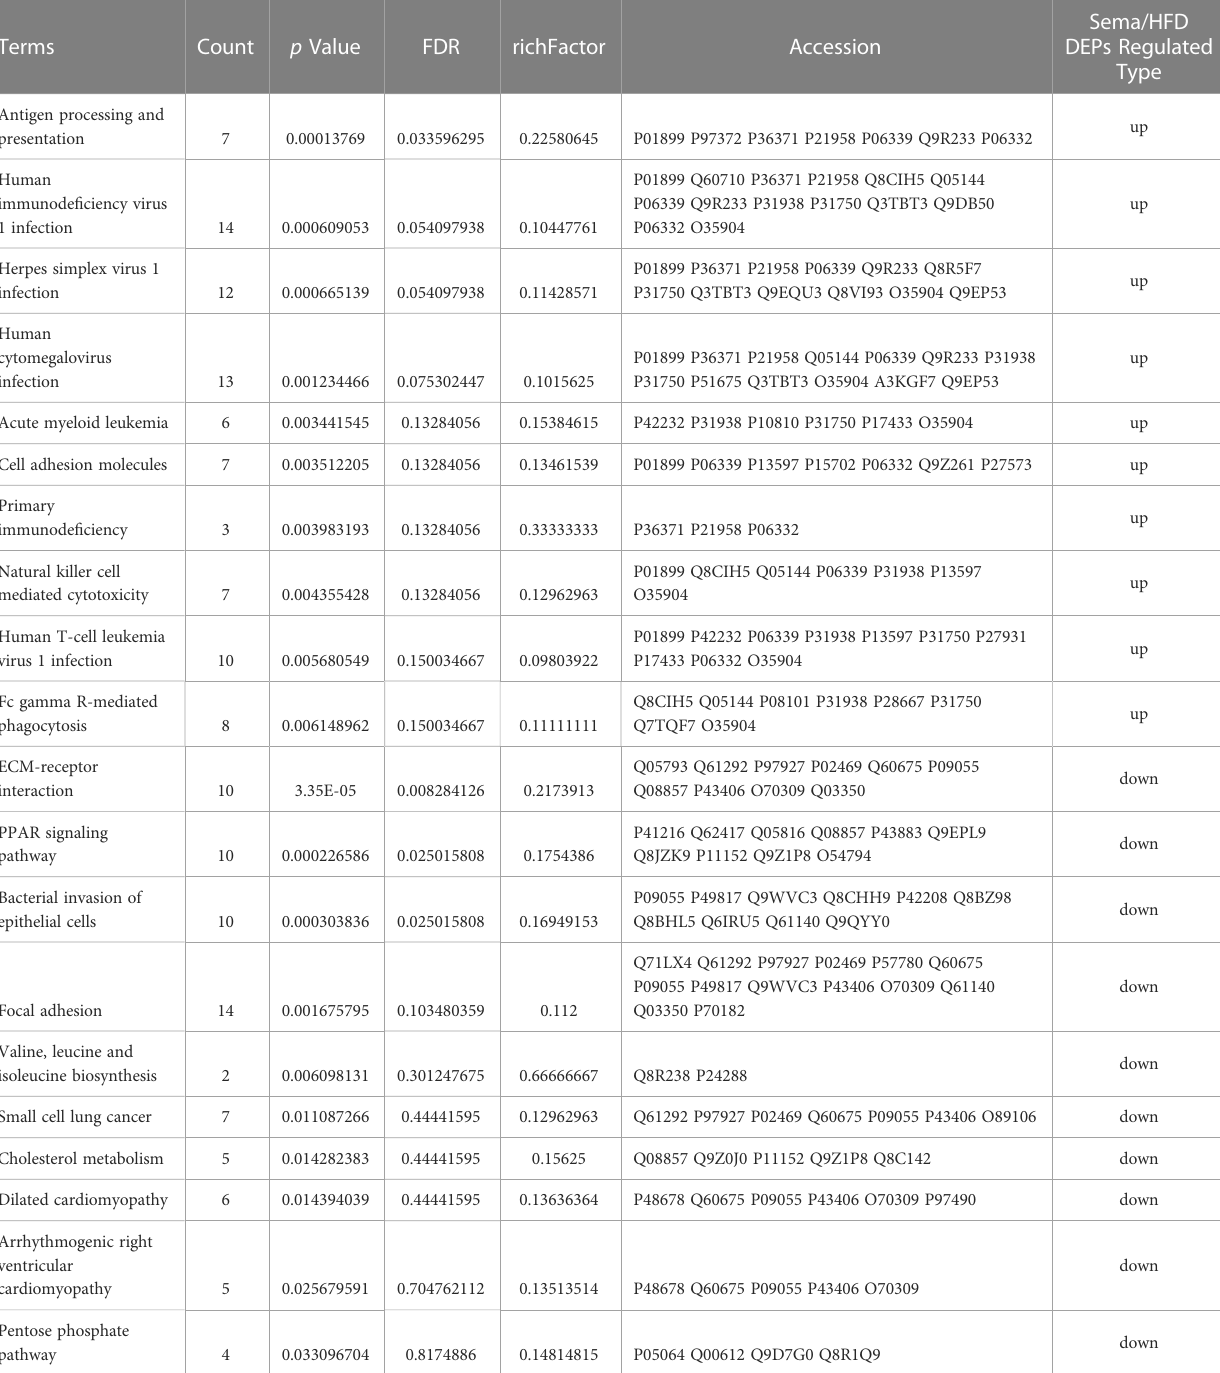
TABLE 4 Signi fi cantly enriched pathways in up/down regulated DEPs between Sema and HFD groups identi fi ed through KEGG pathway enrichment